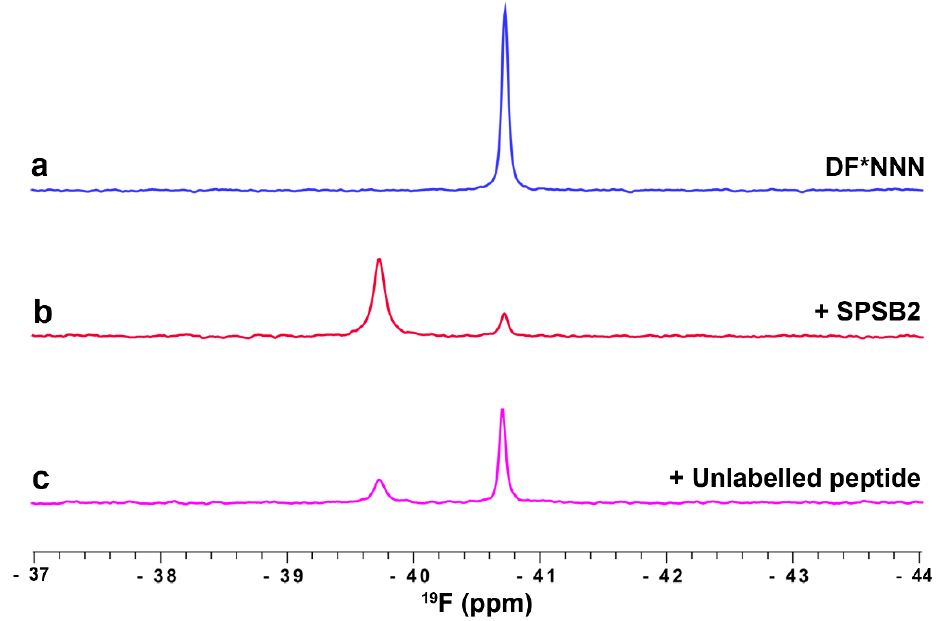
Figure 4. Fluorinated peptide ligand binding to SPSB2. 19 F-NMR spectra of 100 μ M fluorinated DF*NNN peptide in the absence (blue) and presence (red) of 100 μ M SPSB2. Addition of 100 μ M 13-residue iNOS peptide resulted in partial displacement of DF*NNN from the binding site (magenta). Spectra were recorded at 25 °C in 50 mM sodium phosphate, pH 7.4, 50 mM NaCl, at 564 MHz without 1 H decoupling.